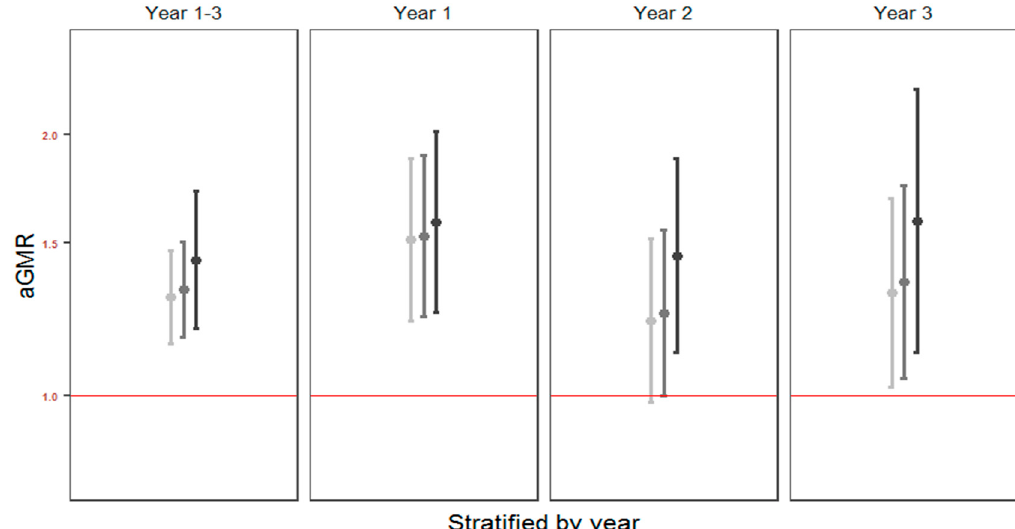
Figure 3. Costs by mode of delivery. The associations between cesarean delivery and costs adjusted for fish-oil supplementation during pregnancy. Adjusted geometric mean ratios of the associations between cesarean delivery and standardized total costs (light grey), observed total costs (middle grey) and direct costs (dark grey) with corresponding 95% confidence intervals stratified by year of life.